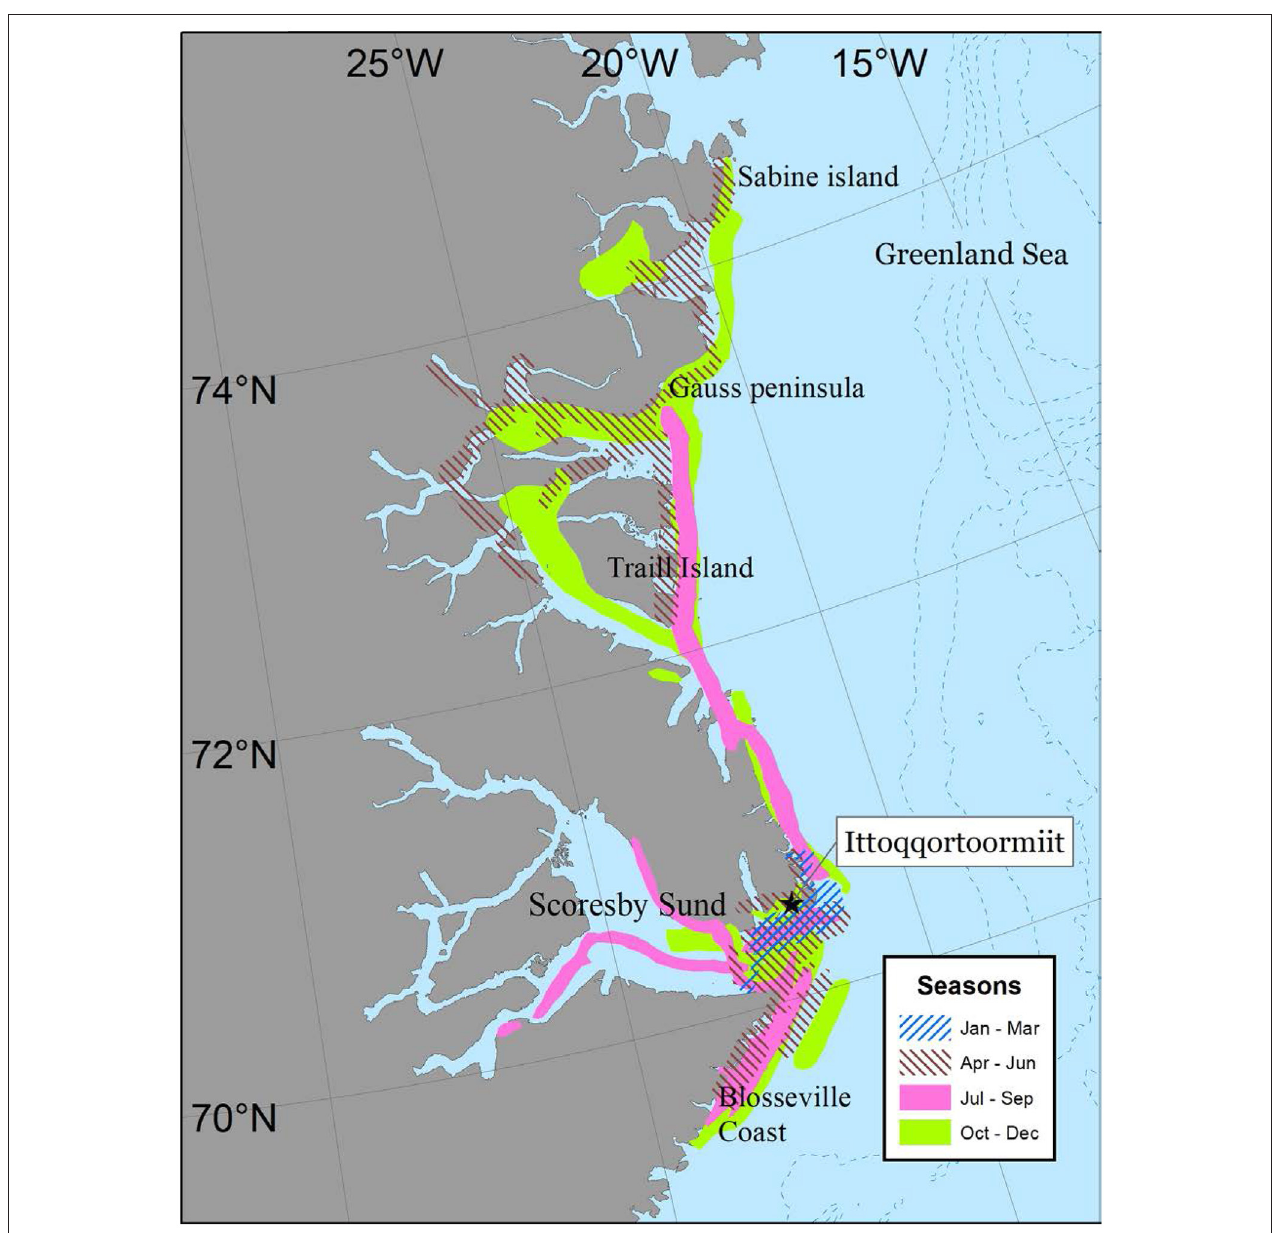
FIGURE 5 | Map of consolidated responses from Ittoqqortoormiit hunters ( n = 7) illustrating seasonal polar bear